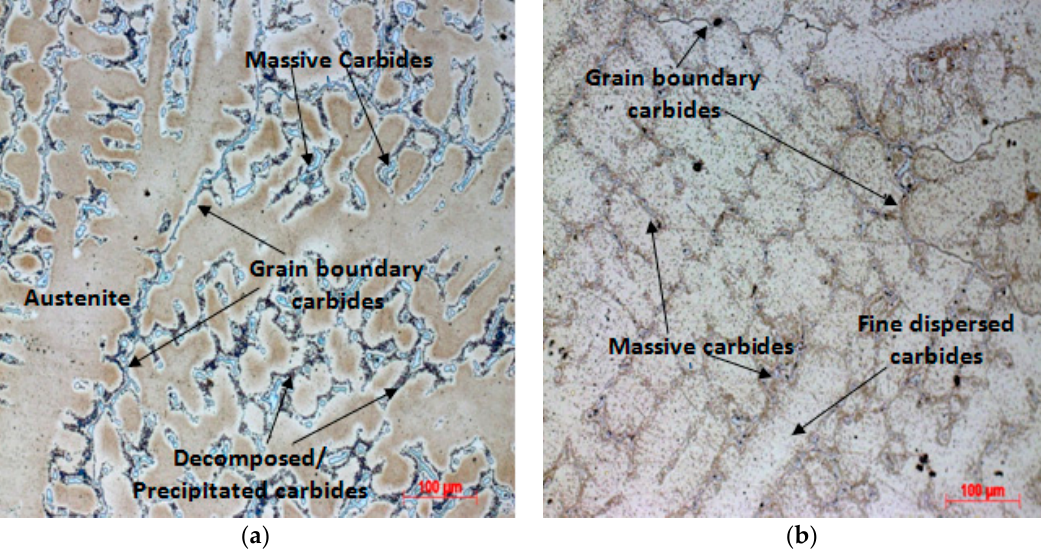
Figure 7. ( a ) Microstructure obtained after solution annealing at 1200 °C for 1.5 h followed by oven cooling and aging; ( b ) Sample solution annealed at 1200 °C for 3 h followed by oven cooling.